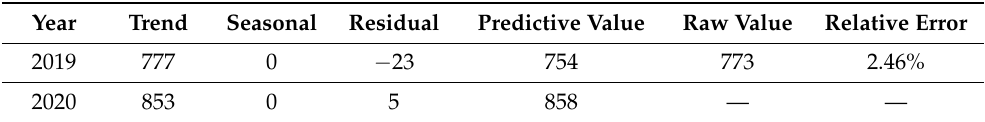
Table 4. Monthly forecast and additional results of housing municipal engineering production safety accidents after trend